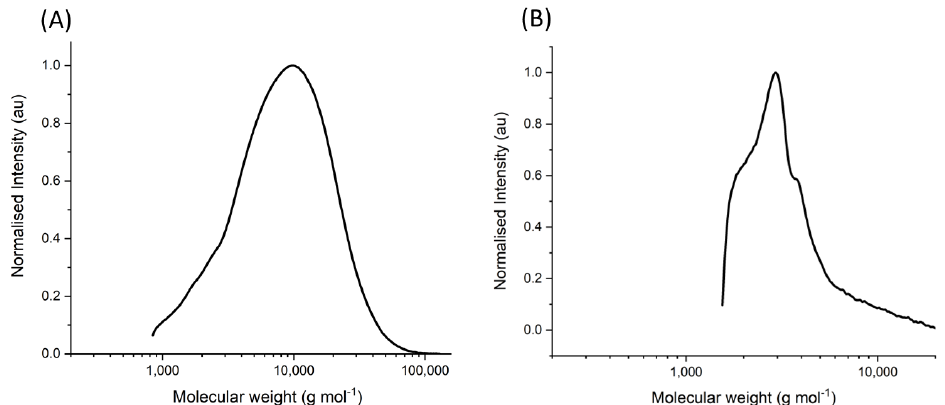
Figure 2. Gel permeation chromatogram of the synthesized copolymer. ( A ) The molecular weight distribution of NIPAM–acrylamide–methacrolein copolymer synthesized in free solution at a starting molar ratio of 45:45:10, respectively. ( B ) The molecular weight distribution of the equivalent copolymer synthesized on the surface of SPIONs at a starting molar ratio of 45:45:10, respectively. Molecular weight intensity is normalized to the logarithm of the peak maxima intensities.